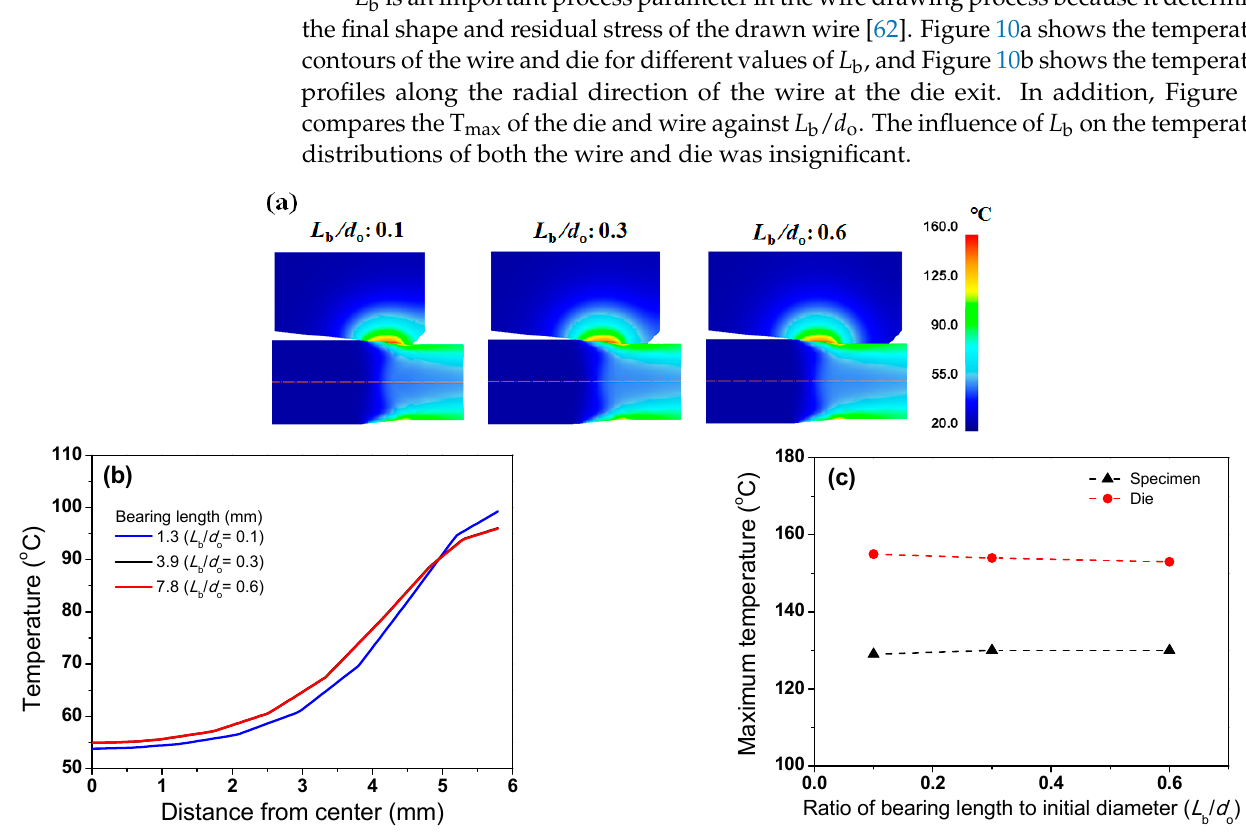
Figure 10. Comparison of temperature ( a ) contours and ( b ) profiles along radial direction of wire at die exit; ( c ) T max of wire and die vs. bearing length.